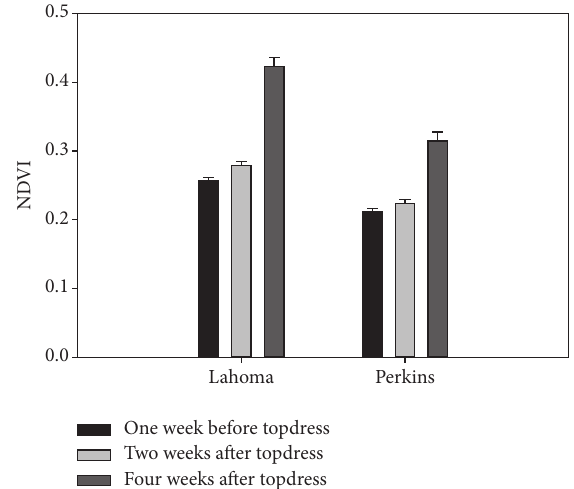
Figure 3: Normalized difference vegetation index (NDVI) values at one week before and two and four weeks after topdress nitrogen (N) at Lahoma and Perkins, OK, in 2012-2013. NDVI values are average across